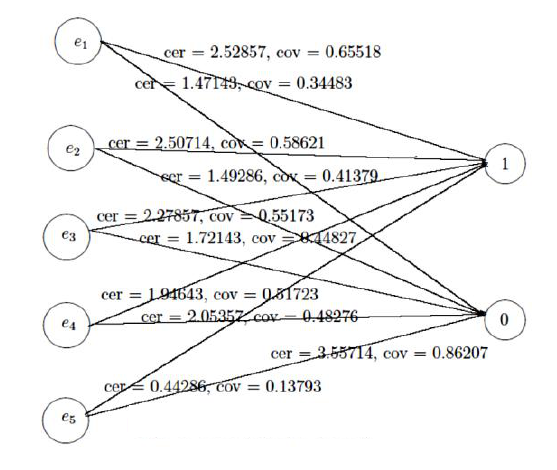
Fig. 3. Flow graph for Table